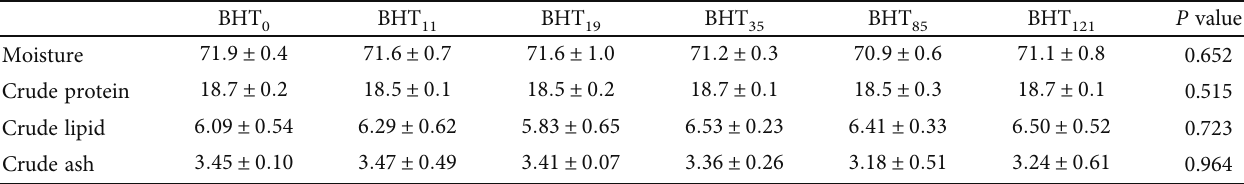
Table 5: Whole-body proximate composition (%, as-is basis) of olive fl ounder ( Paralichthys olivaceus ) fed experimental diets for 120 days 1